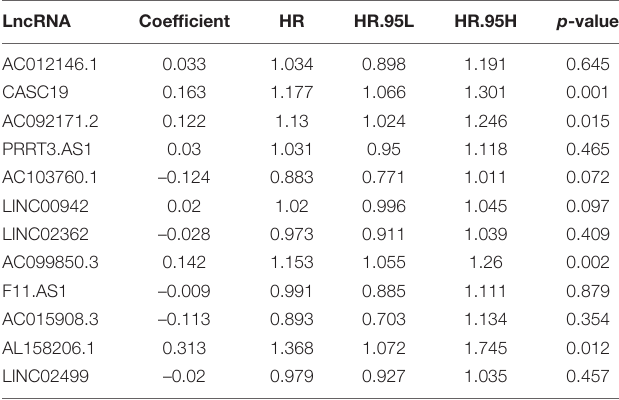
TABLE 2 | Multivariate Cox regression analysis of EMT-related lncRNA. ( Table 3 ), were selected for differential expression analysis in HCC cell lines and tissues samples. We first compared the four lncRNAs expression levels between normal liver cell line L-02 and